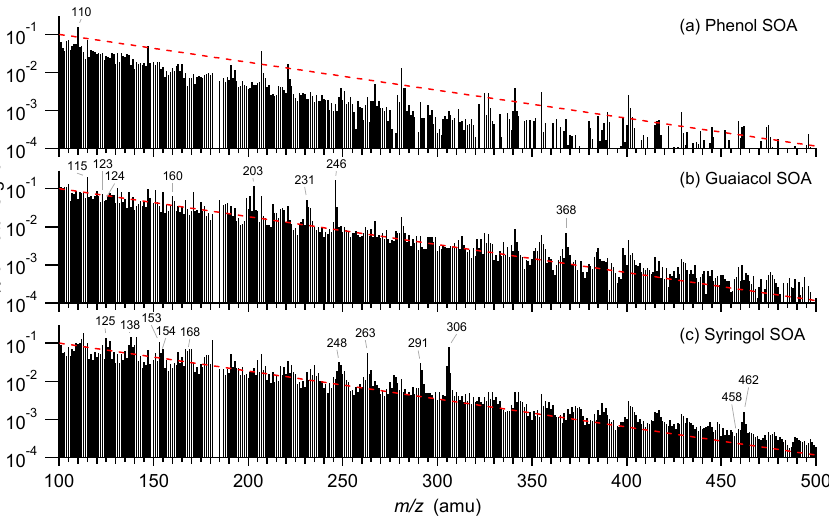
Fig. 4. The unit mass resolution (UMR) spectra ( m/z 100–500) of phenolic SOA produced via aqueous-phase photoreactions in the presence of OH at pH = 5: (a) phenol, (b) guaiacol, and (c) syringol. The red lines are shown to guide the eyes.